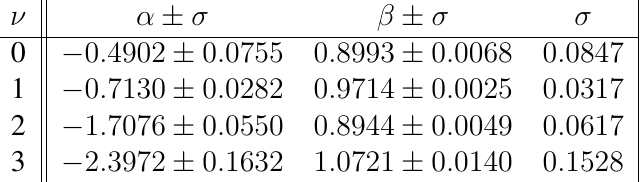
( ν )) = n ( ν )) . Ten n ( ν )) for ν = 0 , 1 , 2 n